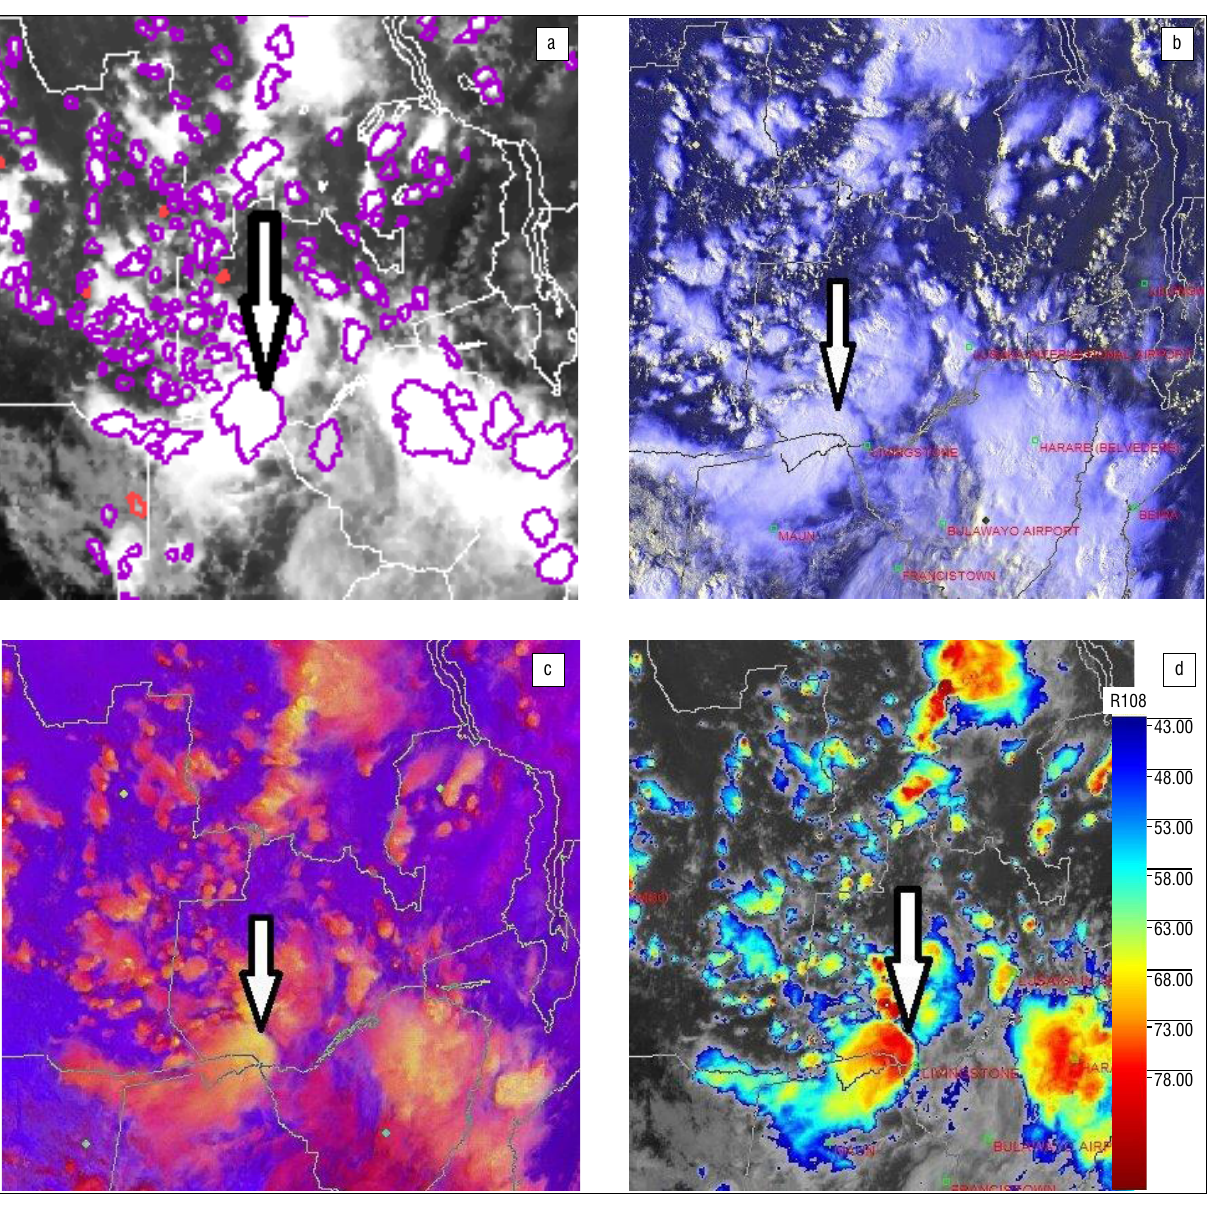
Figure 8: Images for (a) RDT, (b) HRV RGB, (c) convective storms RGB and (d) IR 10.8 colour-enhanced imagery on 21 November 2013 at 15:00 UTC over the central parts of Africa.